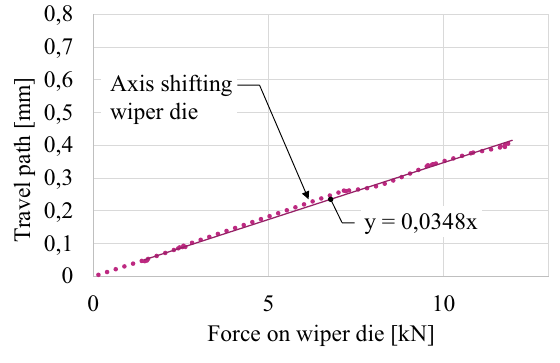
Fig. 19 Axis shifting of the wiper die